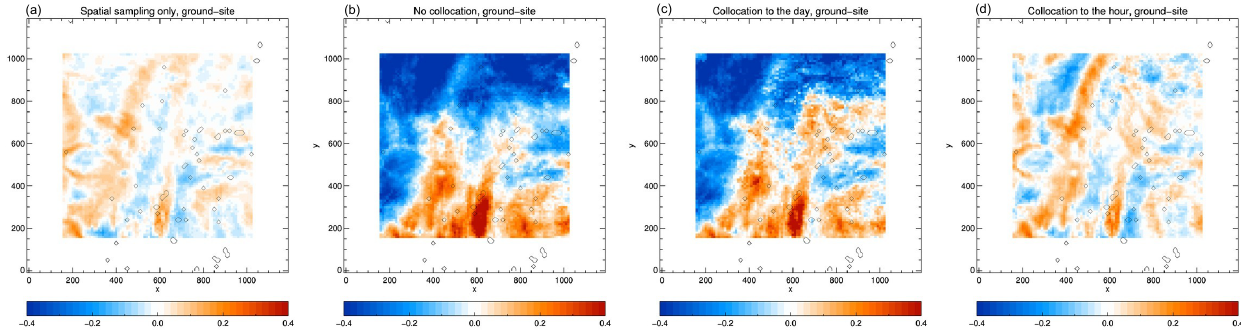
Figure 10. Relative monthly representation errors in AOT for a remote sensing ground site over Oklahoma. From left to right, the following scenarios are considered: (a) only spatial sampling contributes to the representation error; (b) both temporal and spatial sampling contribute; (c) both temporal and spatial sampling contribute but data are collocated to the day; (d) both temporal and spatial sampling contribute but data are collocated to the hour. Results for a 10 × 10km 2 observation against a 210 × 210km 2 area. See also Fig.